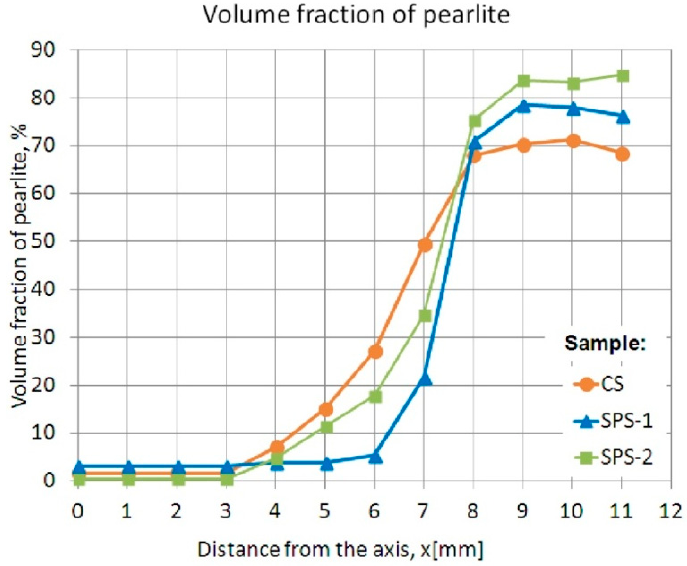
Figure 8. Volume fraction of pearlite as a function of the distance from the axis of products sintered by various methods.